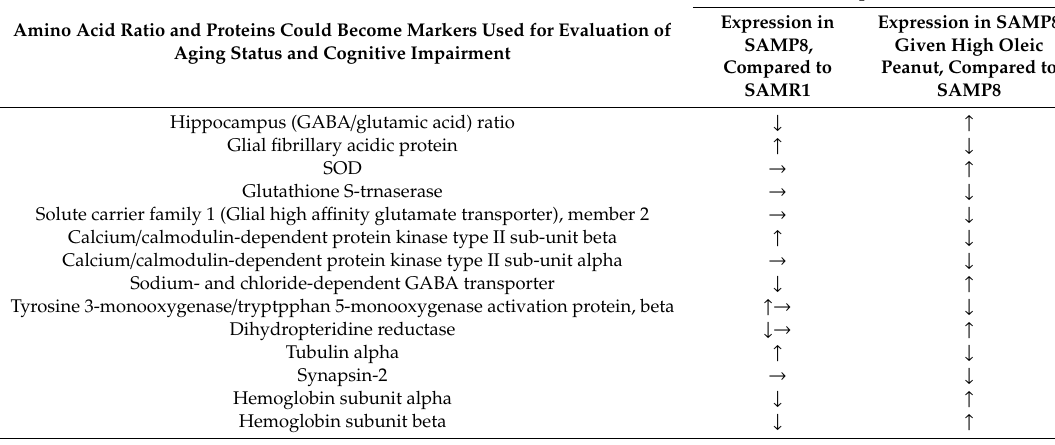
Table 3. Amino acid ratio and proteins could become markers for the determination of aging and cognitive impairment in SAMP8 and its regulation by intake of high-oleic peanuts (peanuts and their germ-rich